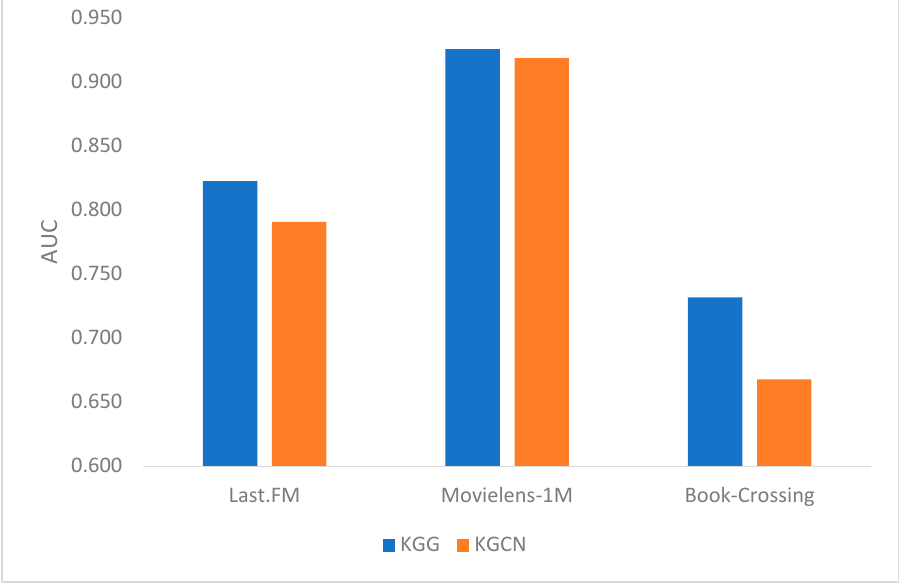
Figure 7. Results of Deletion Experiment.